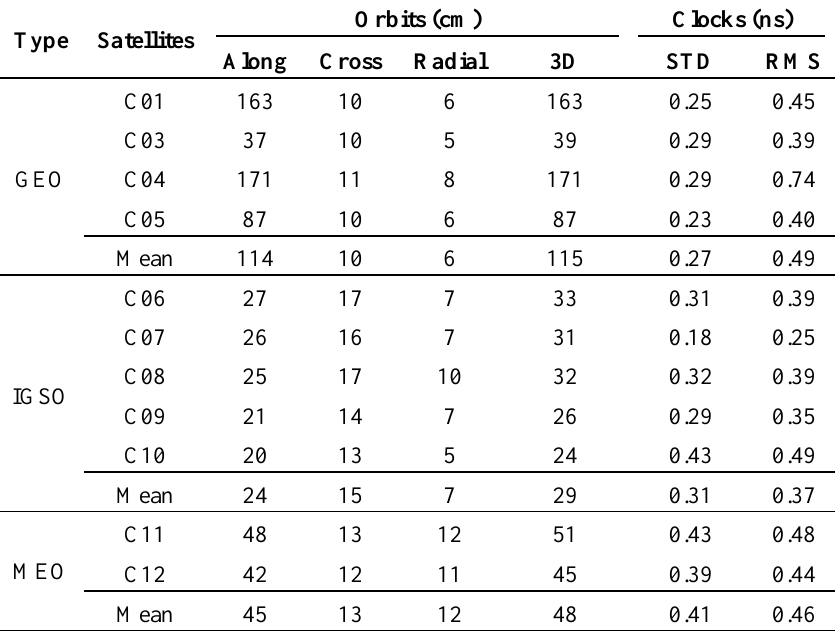
Table 5. Averaged overlapping RMS of the estimated orbits and clocks for each individual satellites and the mean of each satellite